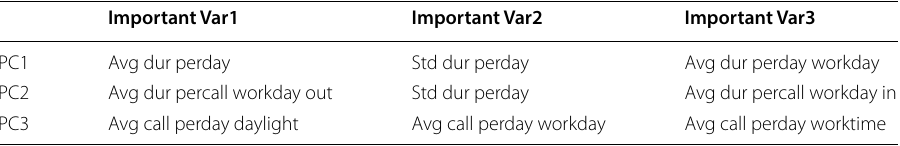
Table 6 The most important features for each component Important